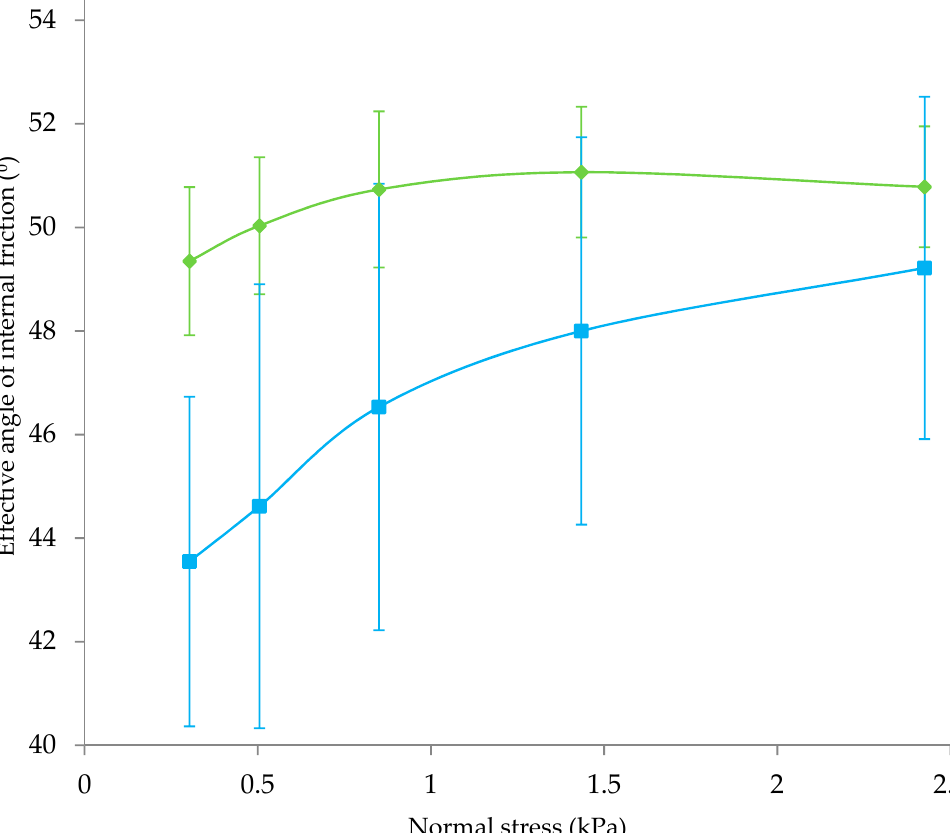
Figure 4. Effect of normal stress on effective angle of internal friction during flow index testing. ( ♦ ) Type I powders; ( ■ ) Type II powders. Note: Type I powders were made from intact proteins and did not contain large lactose crystals; Type II powders were made from intact proteins and contained large lactose crystals.